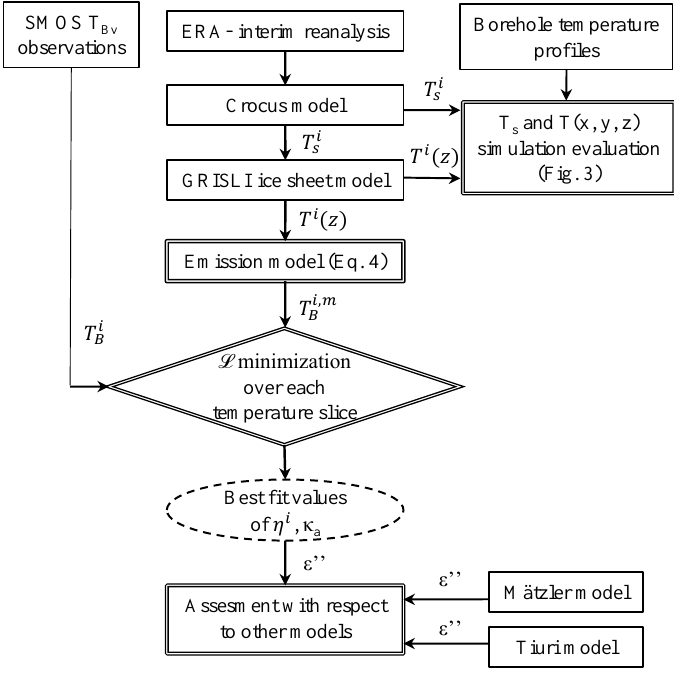
Figure 2. Flowchart of the retrieval method developed in the present